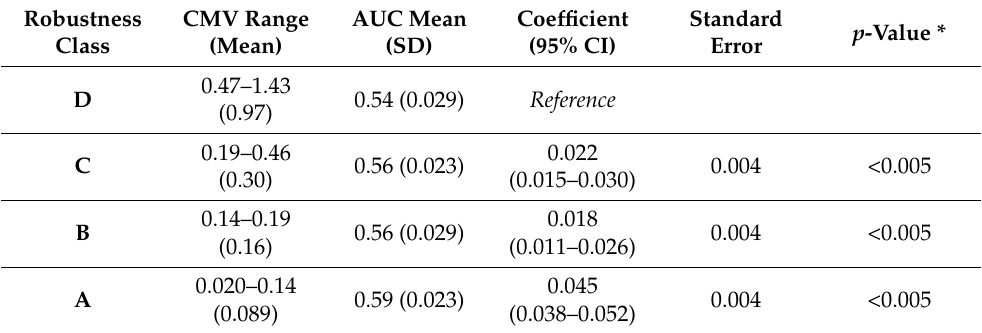
Table 3. Statistical analysis of AUC results in four robustness classes using mixed model logistic regression. The reference class (D) consists of the least robust features. Classes with more robust features (A, B, and C) tend to offer statistically-higher AUCs in case-control classification. Robustness CMV Range AUC Mean Coefficient Standard p -Value * Class (Mean) (SD) (95% CI) Error 0.47–1.43 D 0.54 (0.029) Reference (0.97) 0.022 0.19–0.46 C 0.004 <0.005 0.56 (0.023) (0.015–0.030) (0.30) 0.018 0.14–0.19 B 0.004 <0.005 0.56 (0.029) (0.011–0.026) (0.16) 0.045 0.020–0.14 A 0.004 0.59 (0.023) (0.038–0.052) (0.089)